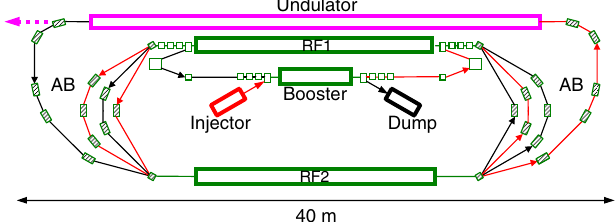
FIG. 3. The scheme of ERL with FEL. RF1 and RF2—rf accelerating/decelerating structures, AB—achromatic bends. Red arrows—accelerating ‘‘fresh’’ beam, black arrows— decelerating used